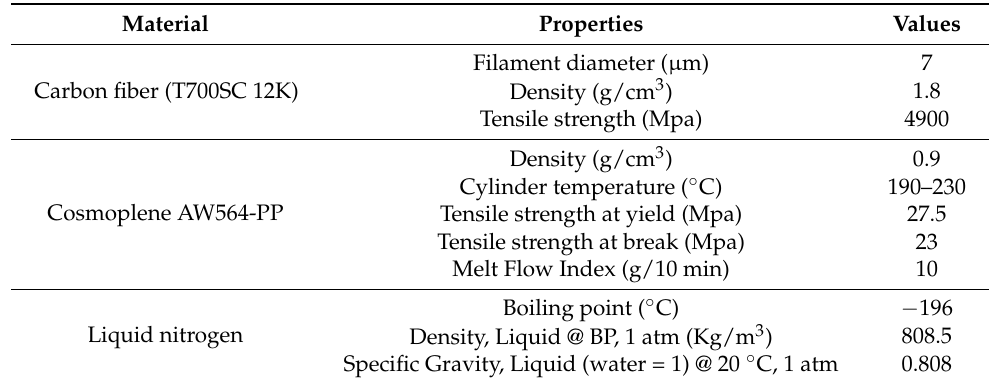
Table 1. Material